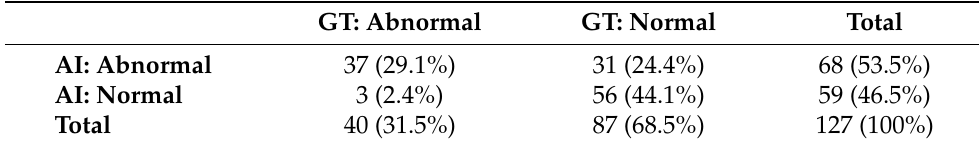
Table 3. DLAD vs. Ground